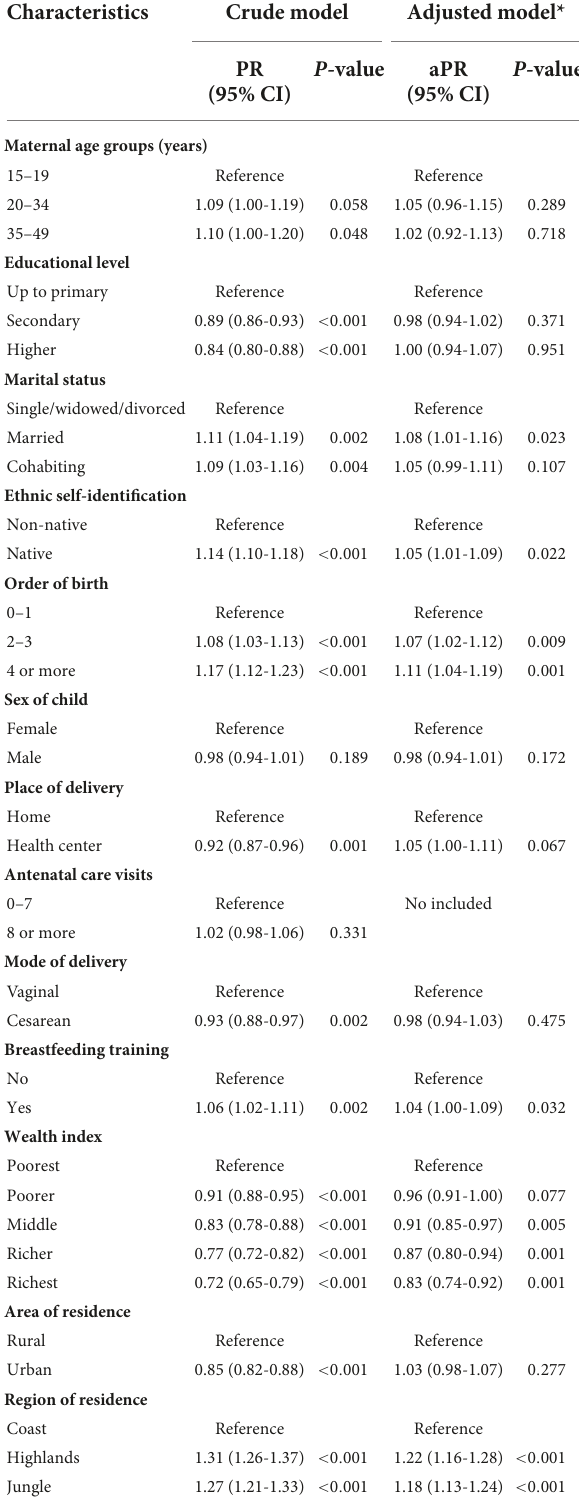
TABLE 3 Factors associated with exclusive breastfeeding (EBF) among infants between 6 and 59 months of age.